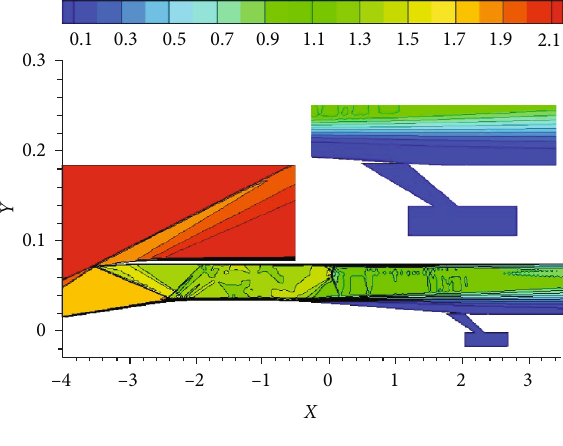
Figure 6: Mach number fl ow fi eld in 0 s.